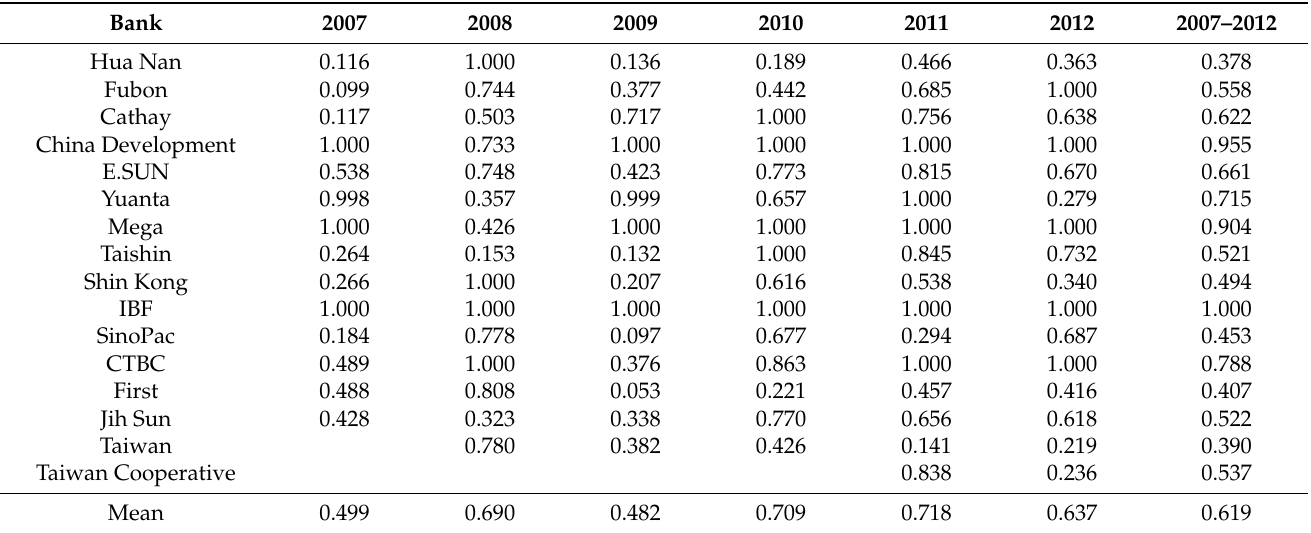
Table 8. Profitability performance for banking service of Taiwanese FHCs in Model 3.